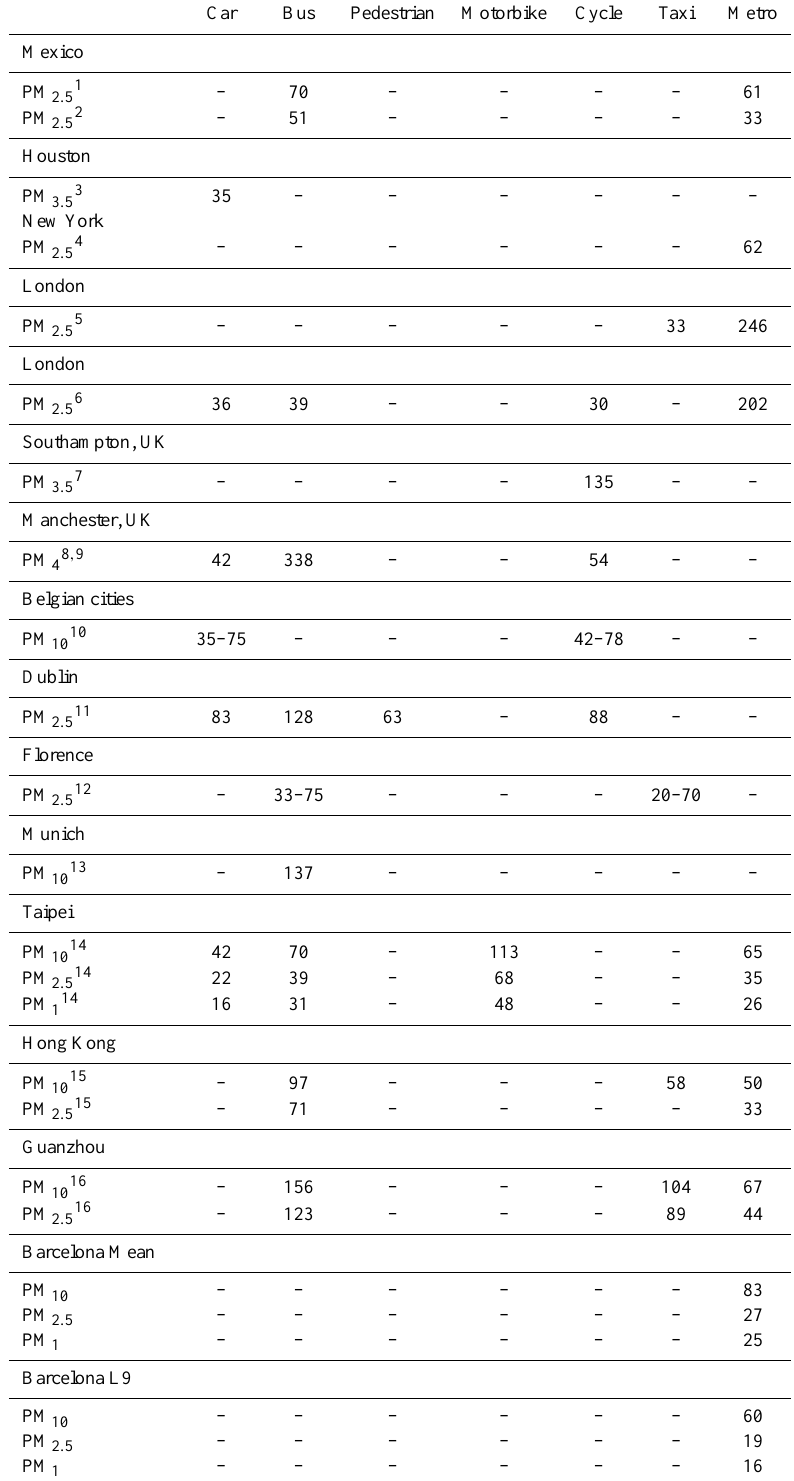
Table 5. PM exposure levels (µgm − 3 ) for different commuting modes in a number of cities of the world. 1. G´omez-Perales et al. (2004); 2. G´omez-Perales et al. (2007); 3. Morandi et al. (1988); 4. Chillrud et al. (2004); 5. Pfeifer et al. (1999); 6. Adams et al. (2001); 7. Bevan et al. (1991); 8. Gee et al. (1999); 9. Gee and Raper (1999); 10. Int Panis et al. (2010); 11. McNabola et al. (2008); 12. Fondelli et al. (2008); 13. Praml and Shierl (2000); 14. Tsai et al. (2008); 15. Chan et al. (2002a); 16. Chan et al.